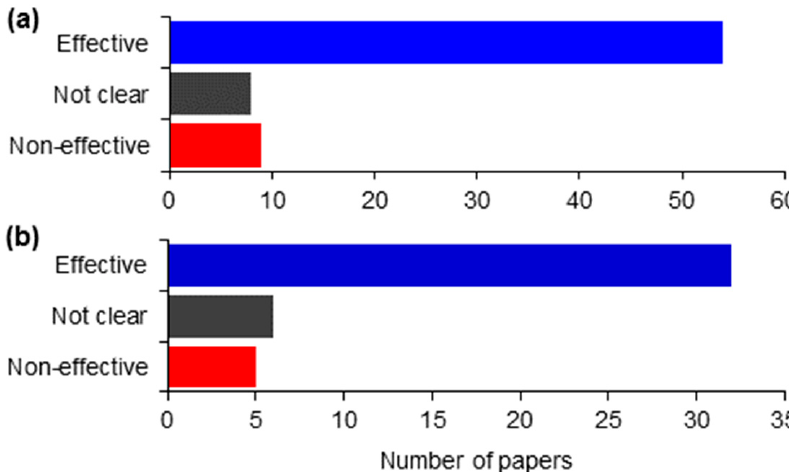
Figure 11. Main conclusion about the effectiveness of ( a ) organic matter decomposition ( n = 71; field studies that did not discriminate the effectiveness of organic matter decomposition from that of other functional indicators were excluded, n = 4; Table S3) and ( b ) ecosystem metabolism ( n = 43) as bioassessment tools of stream functional integrity in bioassessment studies.